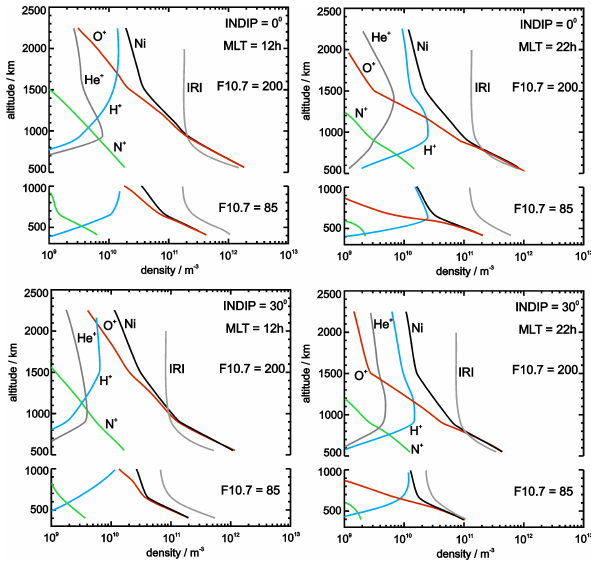
Fig. 8. Equinoxial daytime and nighttime vertical profiles of abso- lute densities for the four main ions as derived from the proposed N e model and from the relative ion composition TTS model. The total ion density N i following from our model and the IRI (Bilitza, 1990) values are shown.